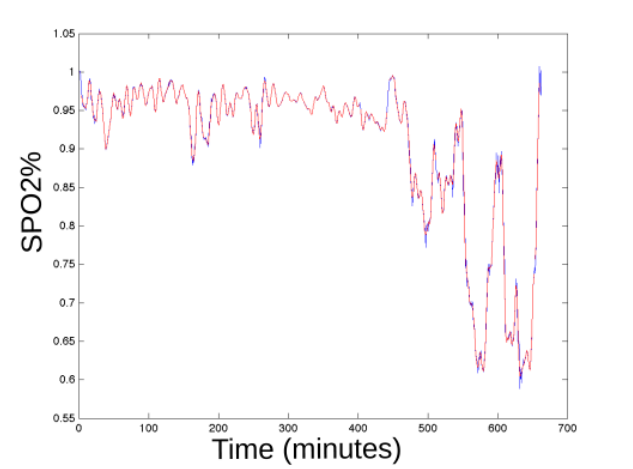
Fig. 5: Compression Results on one of the VSM1 signals. In RED the original signal, in BLUE the reconstructed